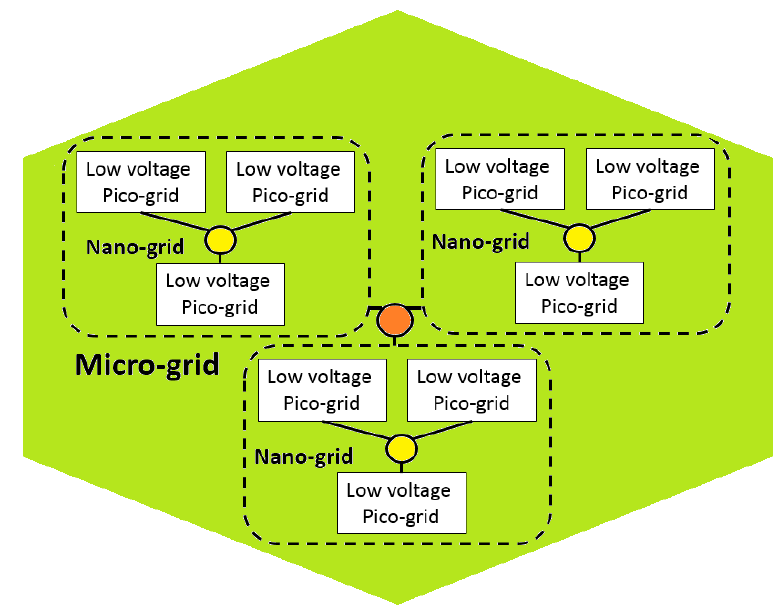
Figure 2. Breakdown of functions of smaller grids.